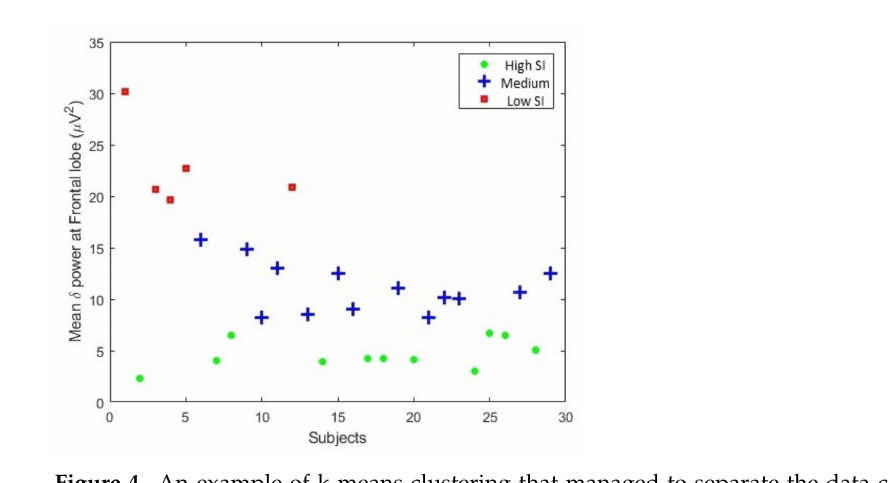
Figure 3. ( a ) Evaluating the optimal number of clusters, k for k-means. ( b ) Estimated clustering threshold, ε , determined for DBSCAN.